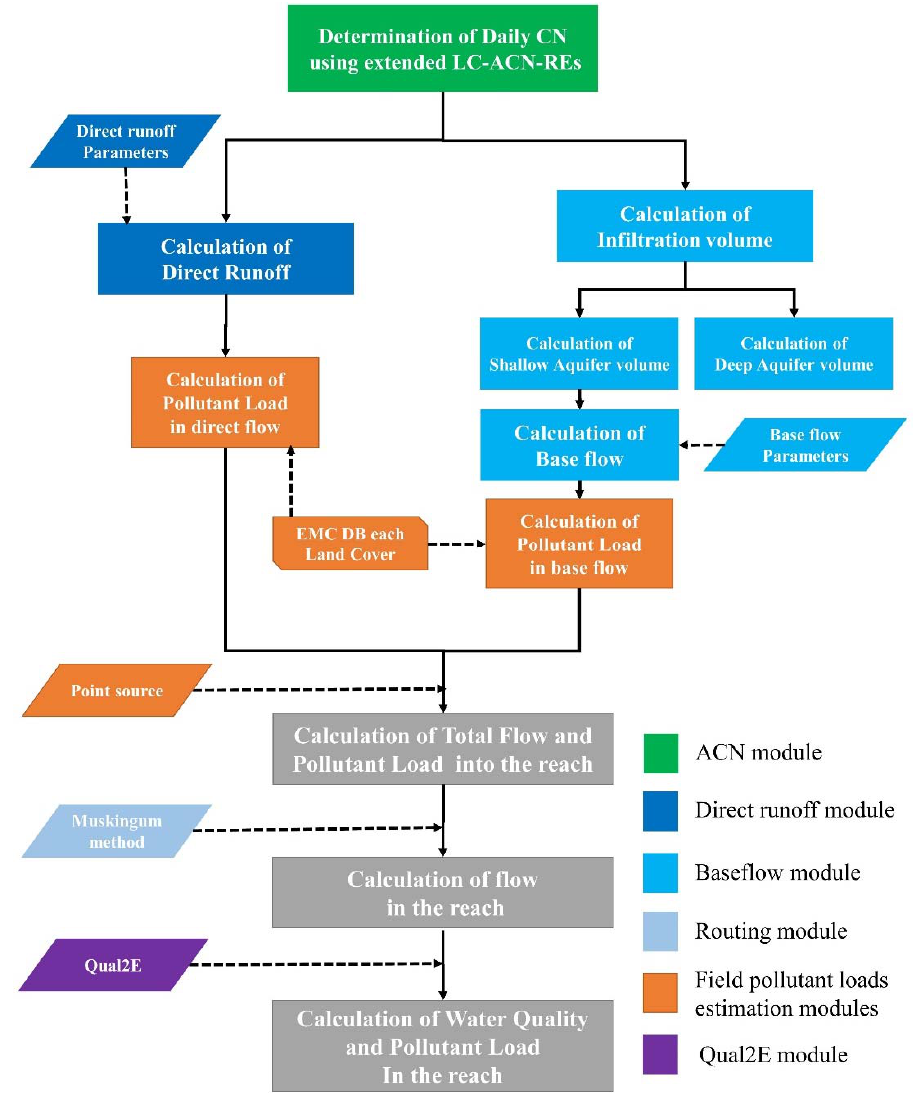
Figure 1. Flow diagram for development of watershed ‐ scale L ‐ THIA ACN ‐ WQ (Long Term Hydrologic Impact Assessment Asymptotic Curve Number ‐ Water Quality) model.